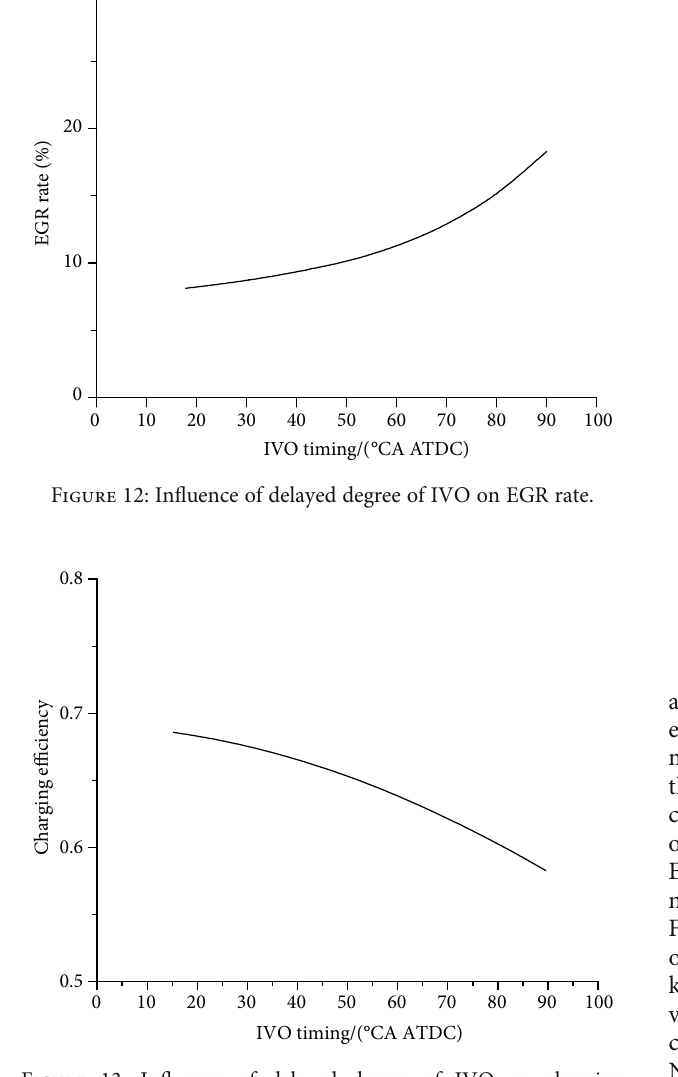
Figure 13: In fl uence of delayed degree of IVO on charging e ffi ciency.